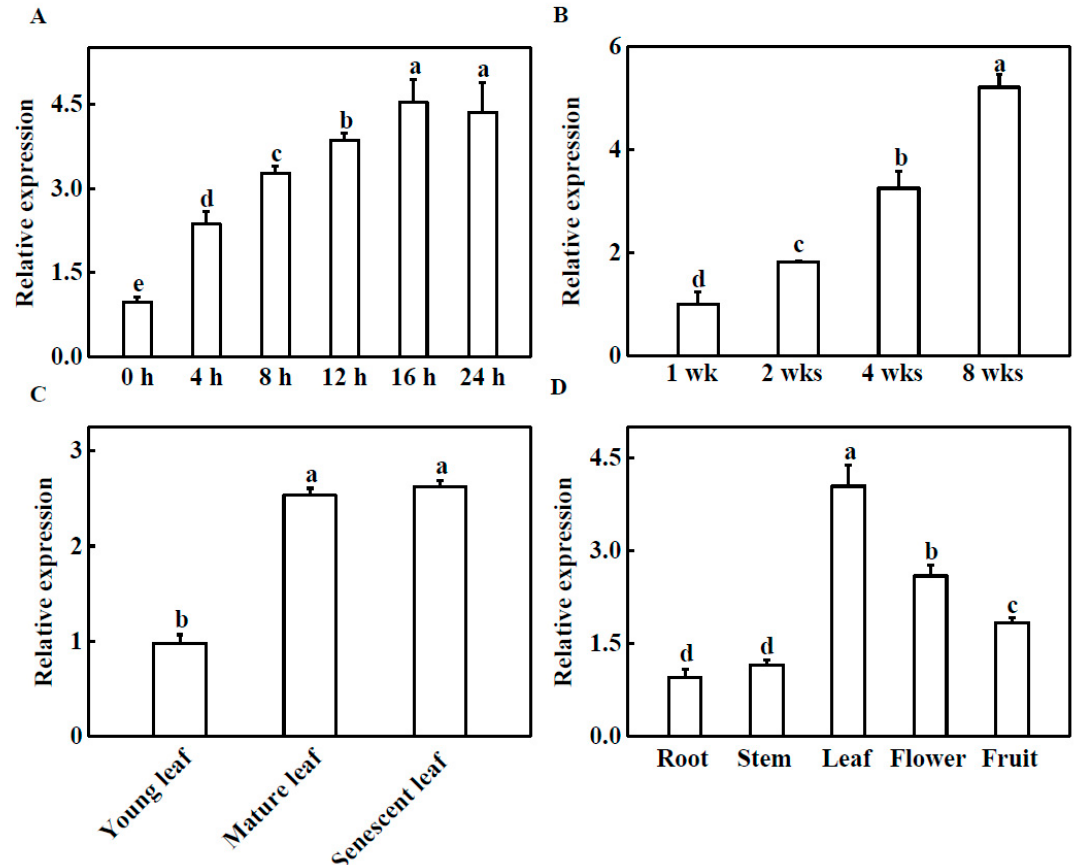
Figure 1. Expression profiles of TGase . ( A ) Light-induced TGase expression in cucumber. The cucumber seedlings were exposed to light 0, 4, 8, 12, 16 and 24 h and TGase transcript levels were analyzed by quantitative real-time PCR (qPCR). ( B ) Transcript levels of TGase in cucumber leaves at 1, 2, 4, 8 weeks of development. ( C ) Transcript levels of TGase in young, mature and old leaves of cucumber plants. ( D ) qPCR analysis of TGase transcript in roots, stems, leaves, flowers and fruit of cucumber. Each histogram represents a mean ± SE of four independent experiments ( n = 4). Different letters indicate significant differences between treatments ( p < 0.05) according to Duncan’s multiple range test.